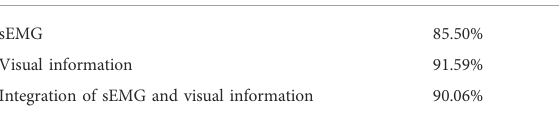
TABLE 2 Gesture classi fi cation comparison. The result is calculated during the sweet period among 900 grasp trials from 30 subjects with leave-one-repetition-out